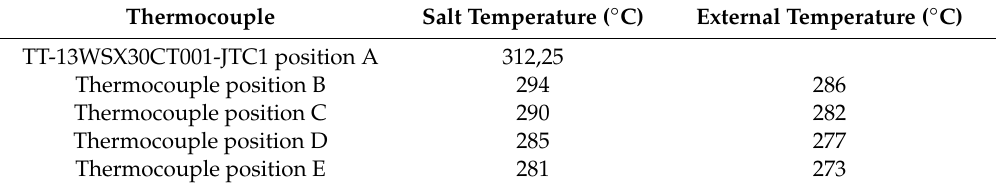
Figure 1. Cross section of a 35-inch diameter pipe with heat transfer fluid. Table 1. Measurement of the temperature in the solar power plant “La Africana”.